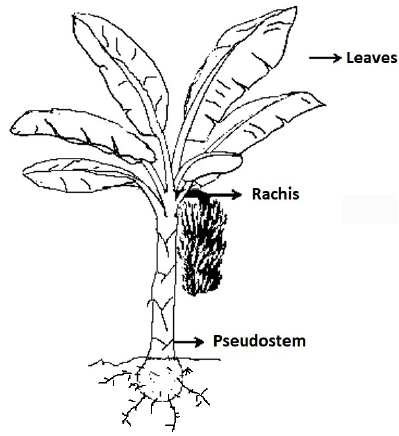
Figure 1. Parts of the banana plant.